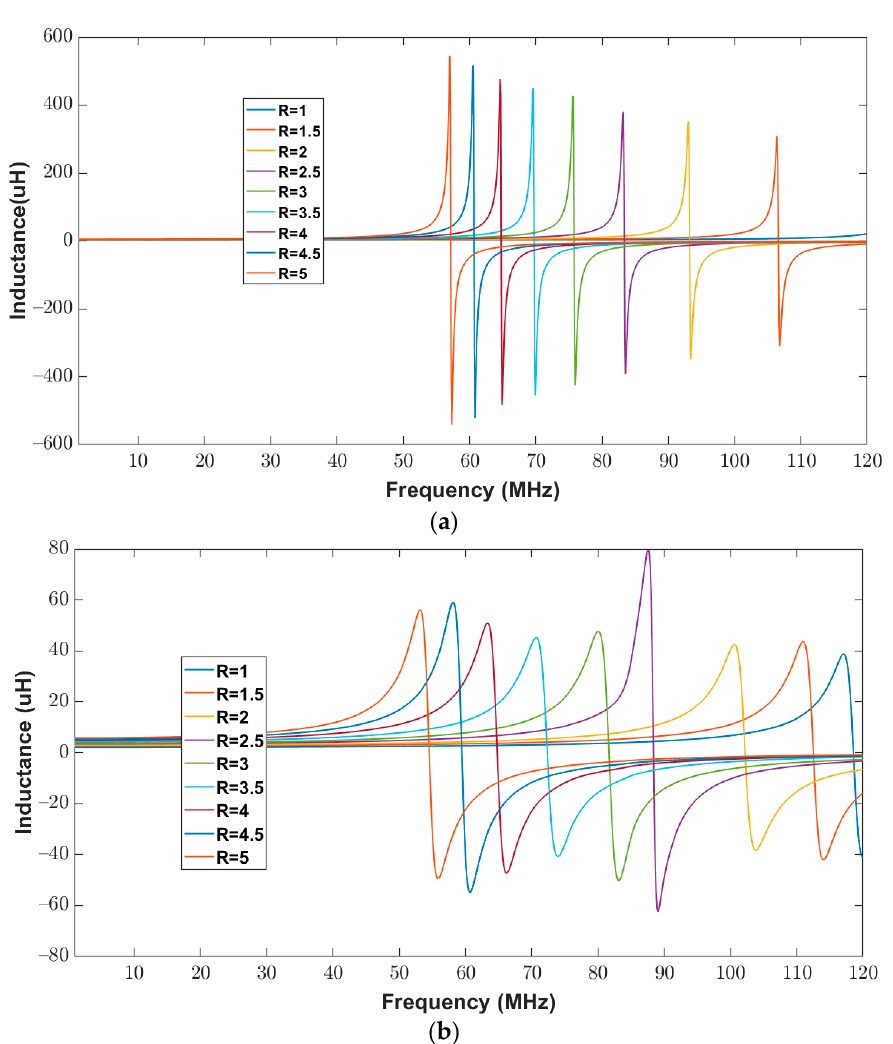
Figure 14. Inductance of elliptical planar inductors for the full range of frequencies from 20 Hz to 120 MHz with varying major-to-minor ratios while trace separation ( S ) and trace width ( W ) were kept constant at 300 μ m ( a ) Computed response using proposed model ( b ) Measured response from the impedance analyzer.